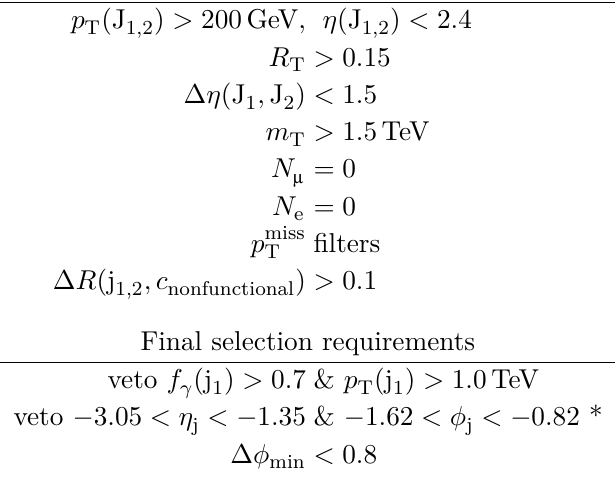
Table 2 . Summary of the preselection and final selection requirements. The symbol * indicates a selection applied only to the later portion of the 2018